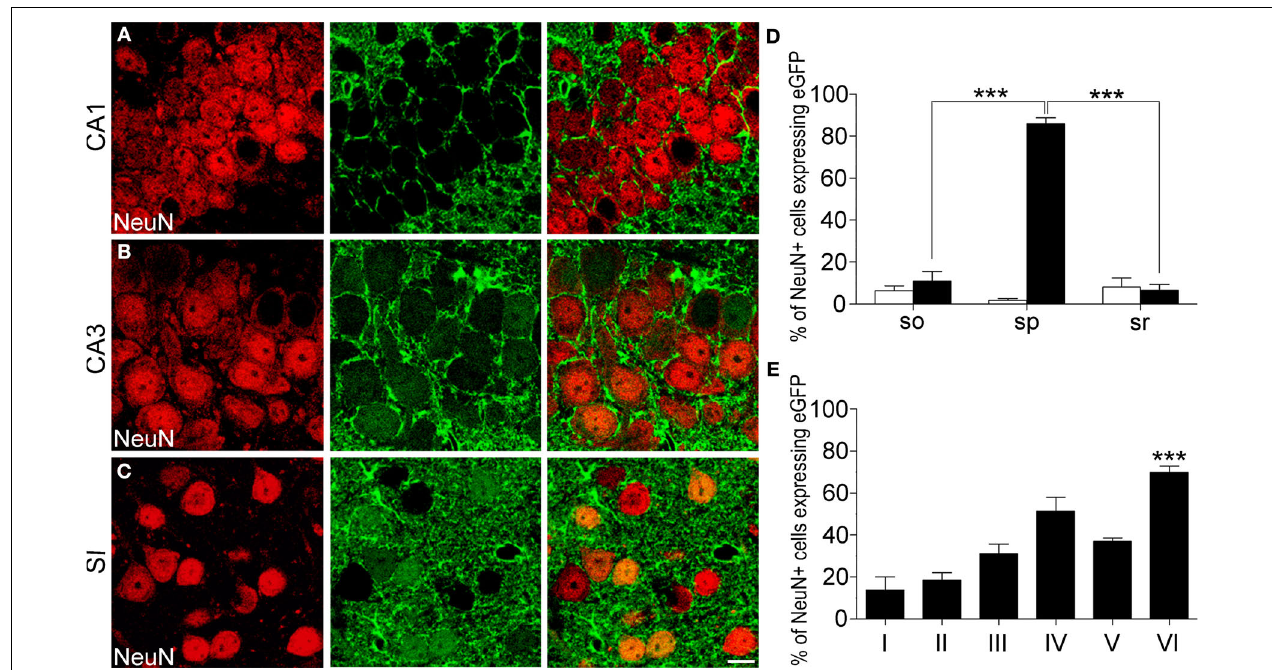
pyramidale (sp), and radiatum (sr) of CA1 ( white columns ) and CA3 ( black columns ). (C) NeuN/eGFP co-localization in layer VI of SI. (E) percentage